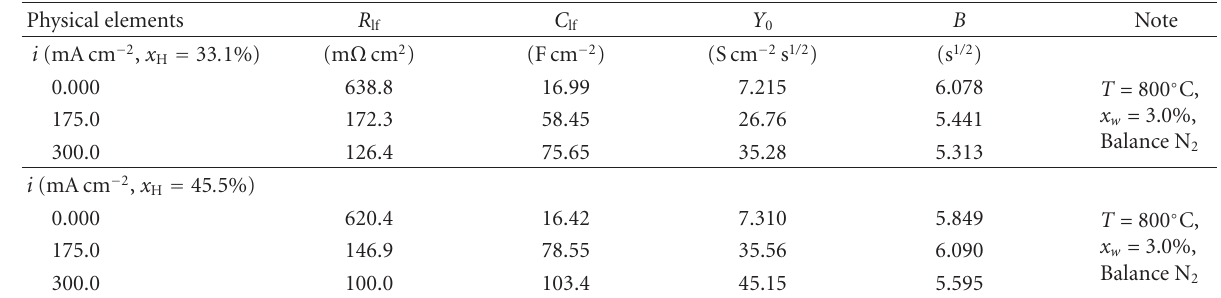
(b) Varied load current density at two hydrogen feed concentrations